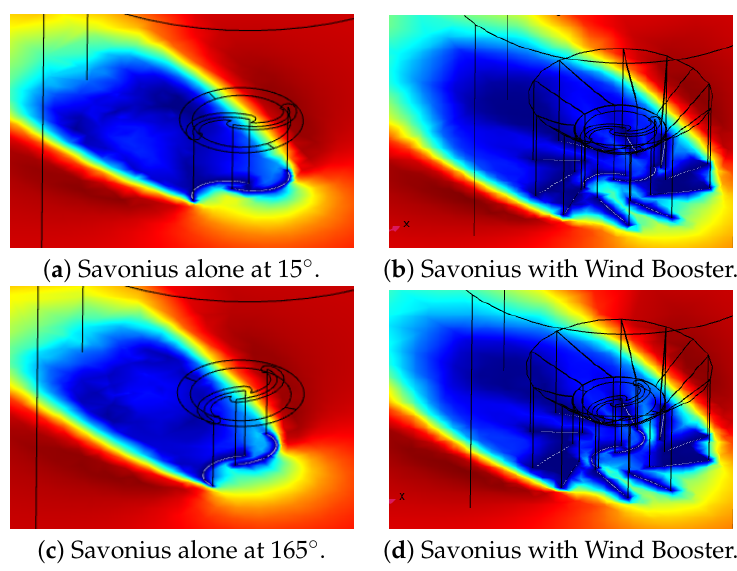
Figure 15. Three-dimensional view of wind flow behavior at 2.04 m/s.